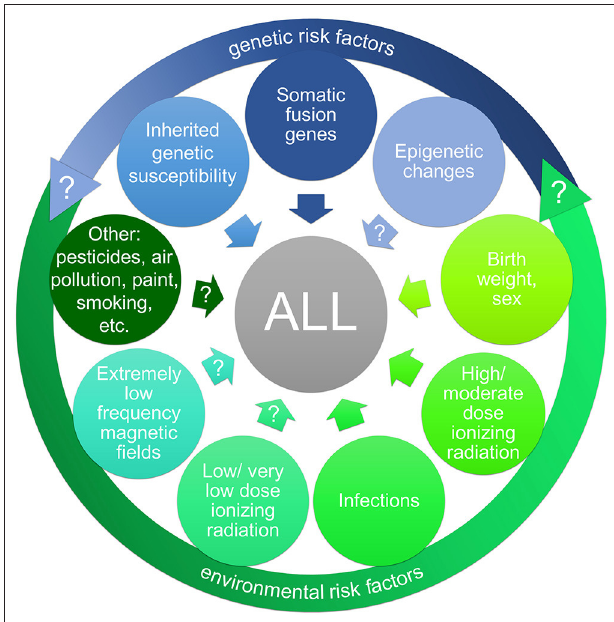
FIGURE 1 | Risk factors (potential and established) for childhood acute lymphoblastic leukemia (ALL). A large body of research has targeted a wide range of possible risk factors for childhood ALL, including genetic risk factors (indicated in blue) and environmental risk factors (indicated in green). The interaction of genetic and environmental risk factors (gene-environment-interaction) may have an impact on ALL development. Inherited genetic susceptibility is detected with increasing frequency in childhood leukemia as well as preleukemic fusion genes as predisposing factors. The impact of epigenetic alterations (possibly induced by oncogenes or environmental exposures) on ALL development is yet unclear. Among the recognized environmental risk factors are high and low birth weight and sex as well as high to moderate doses of ionizing radiation. The relevance of infections as risk factor for ALL has strengthened considerably in the last decade. In contrast, evidence for an association between a higher risk for ALL and exposure to low/very low doses of ionizing radiation, extremely low frequency magnetic fields (e.g., from power lines), and other environmental risk factors (like pesticides or air pollution), respectively, has yet to be